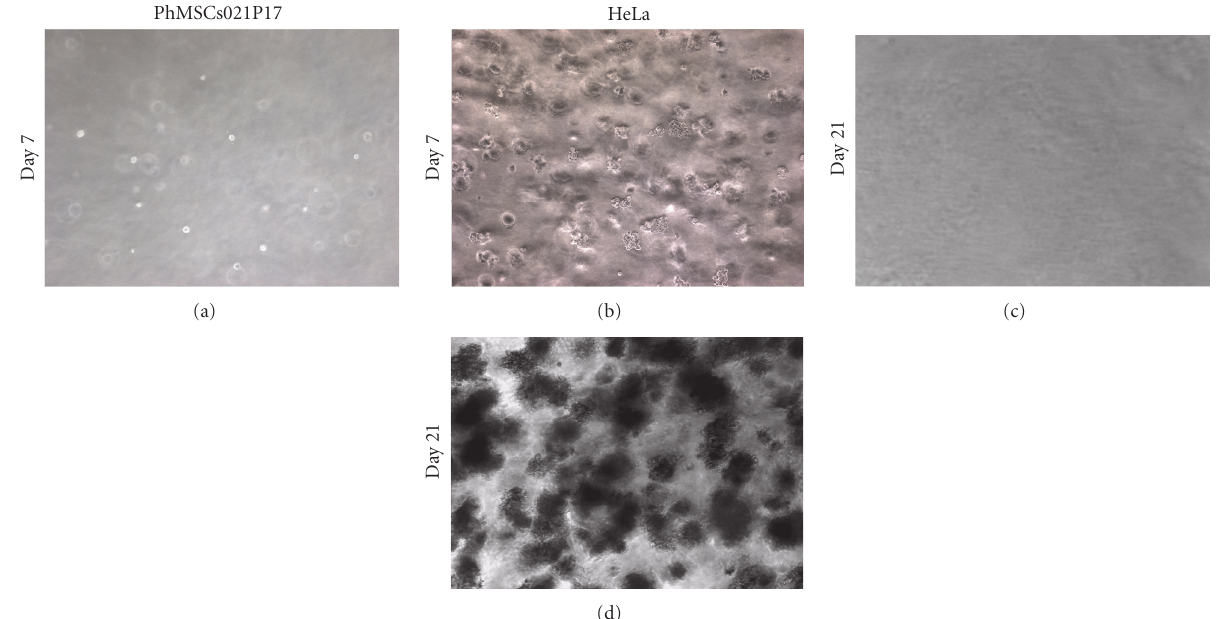
Figure 5: Soft agar assay. (a)Placental MSCs day 7; (b) HeLa cells day 7; (c) Placental MSCs day 21; (d) HeLa cells